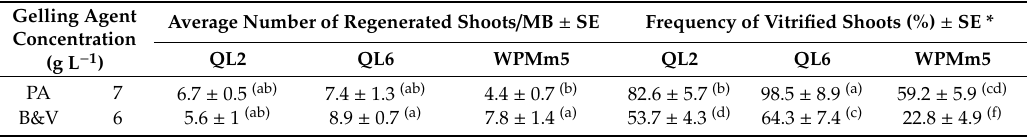
Table 2. Regeneration e ffi ciency and the percentage of vitrified shoots for MB slices cultured for four weeks on regeneration media containing di ff erent gelling